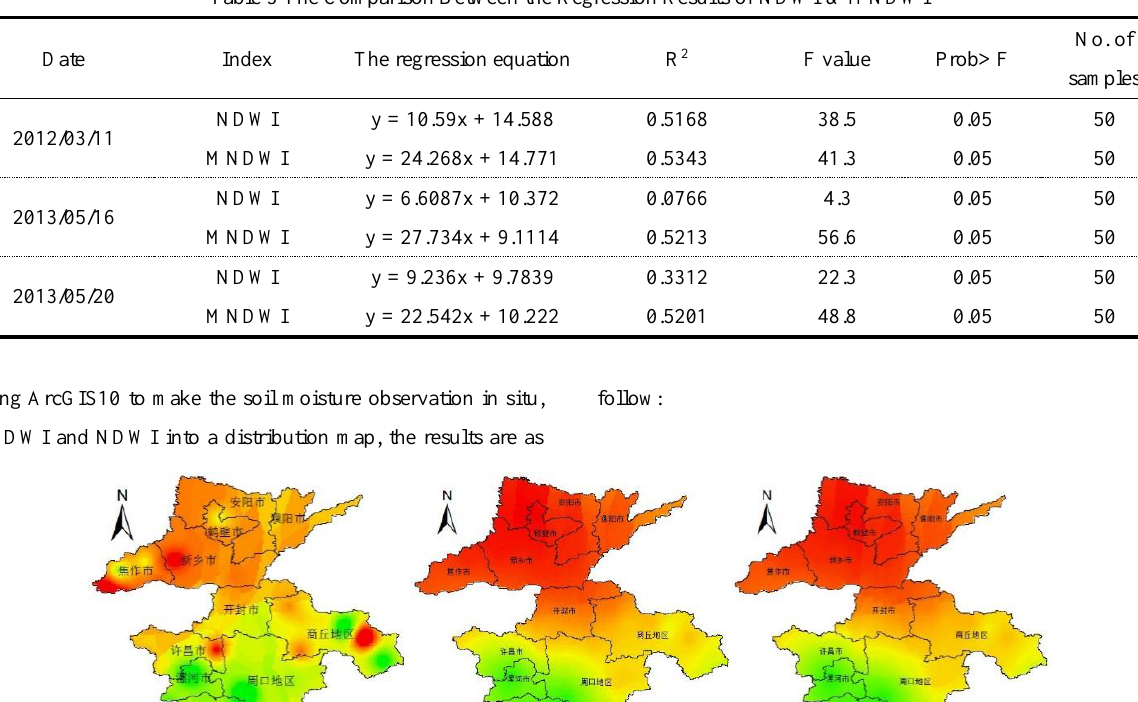
Table 3 The Comparison Between the Regression Results of NDWI &